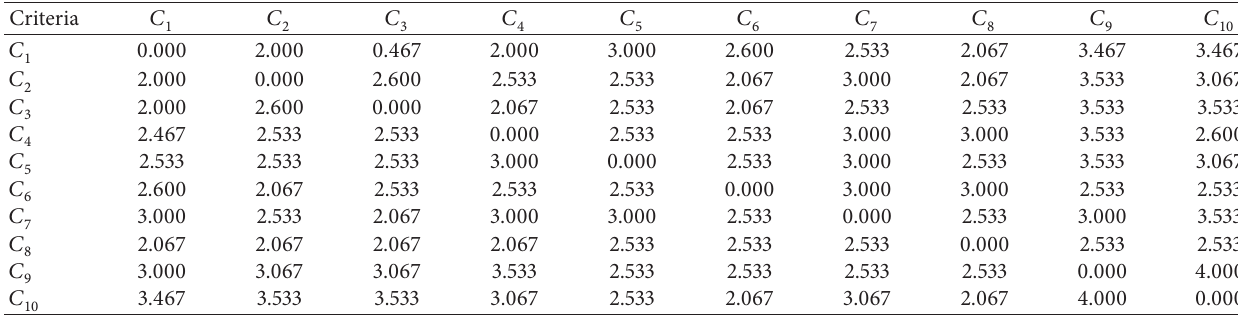
Table 1: The initial influence matrix A .